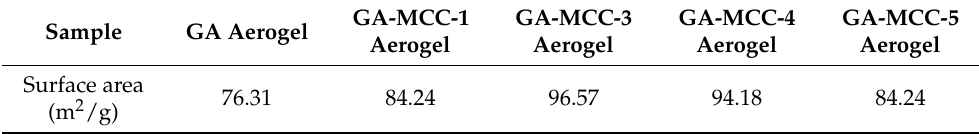
Figure 5. Pore characterization of GA aerogel and GA-MCC aerogels. The nitrogen adsorption-desorption curves and BJH pore distribution curves of ( a ) GA aerogel and ( b – f ) GA-MCC-1 to GA-MCC-5 aerogels. Table 1. Surface area of GA aerogel and GA-MCC-1 to GA-MCC-5